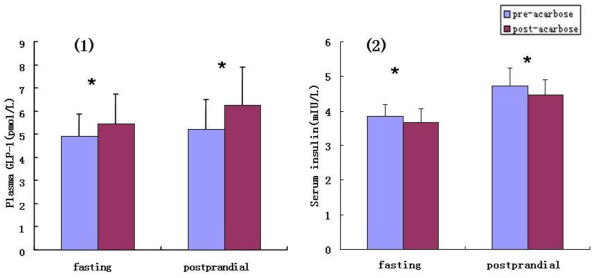
Mean values for plasma GLP-1 and serum insulin pre- and post-acarbose treatment. The values of serum insulin was natural logarithm-transformed; *p < 0.05 for the difference between pre- and post-acarbose treatments.